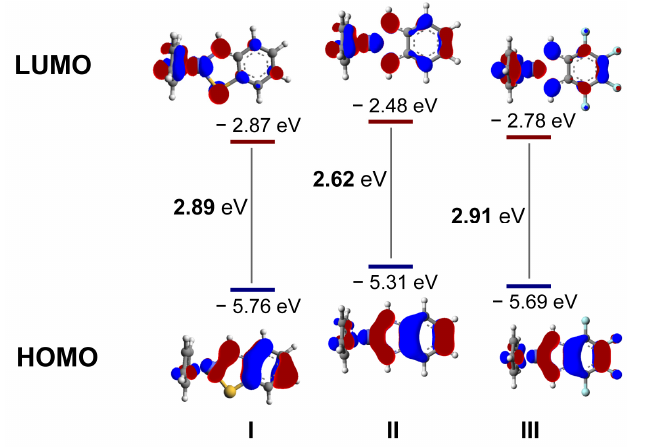
Figure 5. HOMO and LUMO for the neutral derivatives I and II and their corresponding energies and